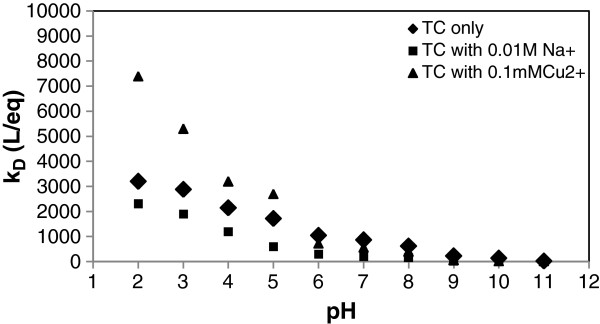
The plot of K
D
against pH.